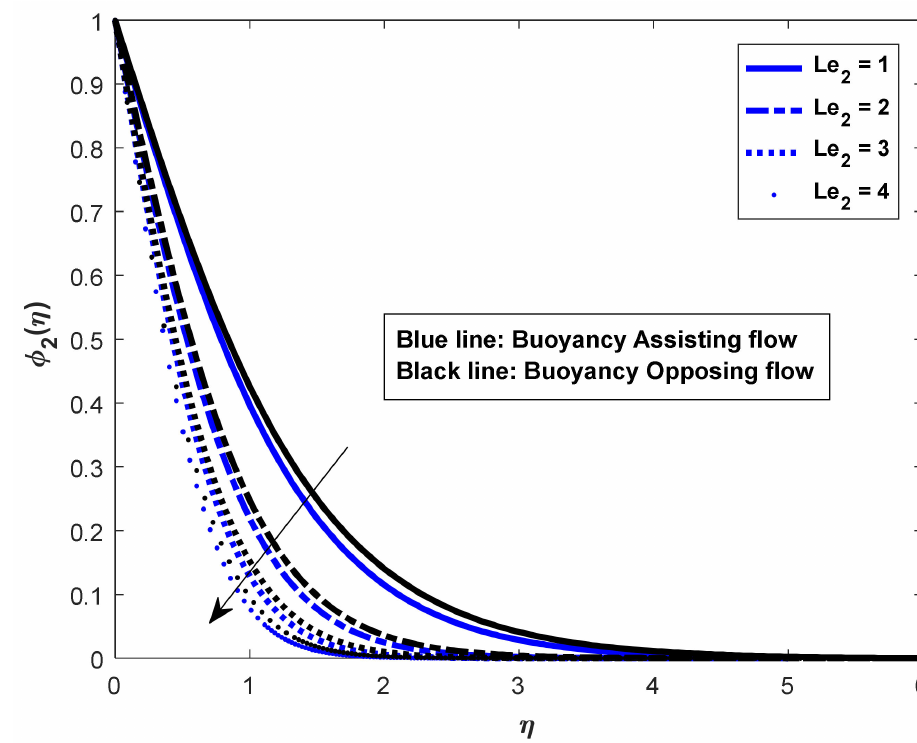
Figure 20. Le 2 on salt_2 concentration.